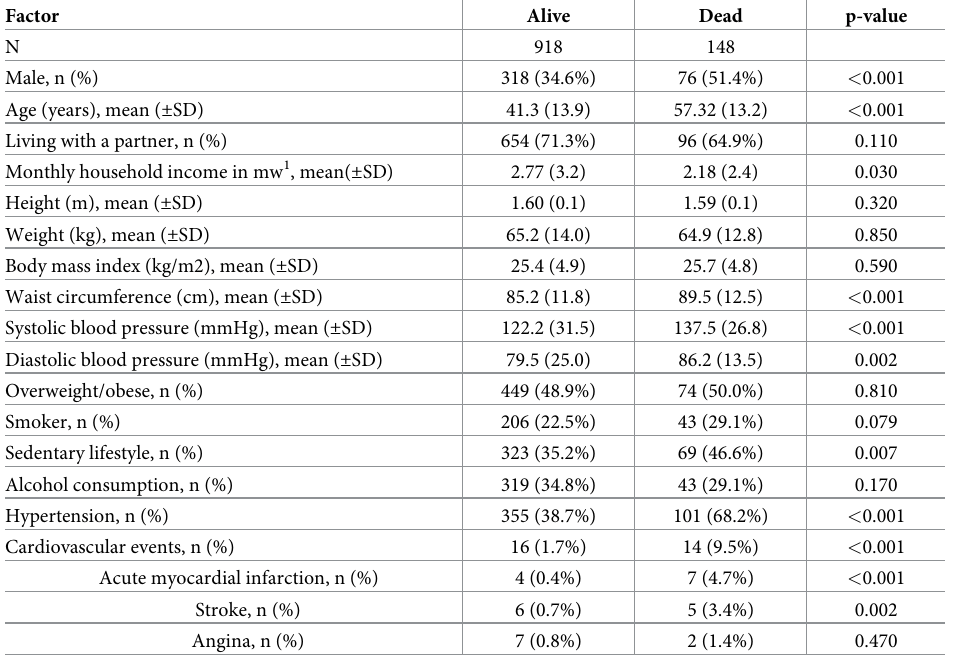
Table 1. Baseline cohort characteristics according to vital status in 2015 (n =